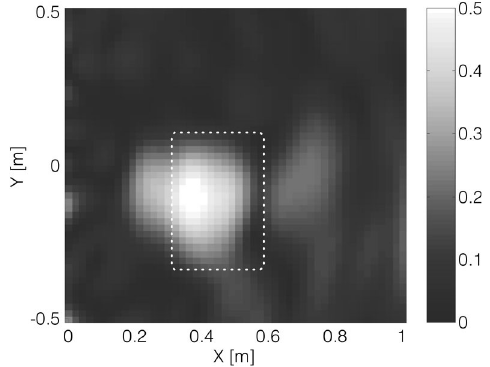
Fig. 5. Case 1: a rectangular void. Modulus of the reconstructed contrast when considering clean data. The reference shape is reported as a contour plot.